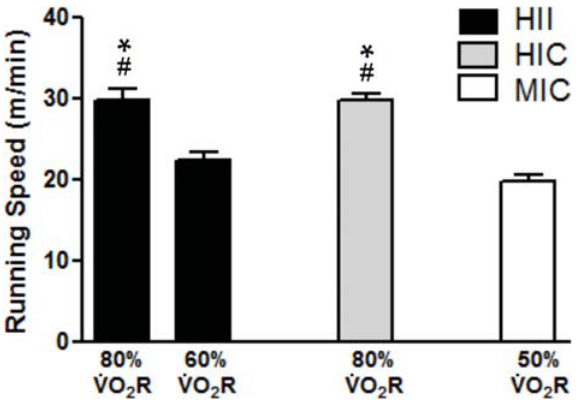
Figure 1. Running speeds (m/min) for each exercise condition : (means ± SE). VO 2 R: reserve oxygen uptake; HII: high-intensity interval exercise; HIC: high-intensity continuous exercise; MIC: moderate-intensity continuous exercise. # P o 0.0001, compared